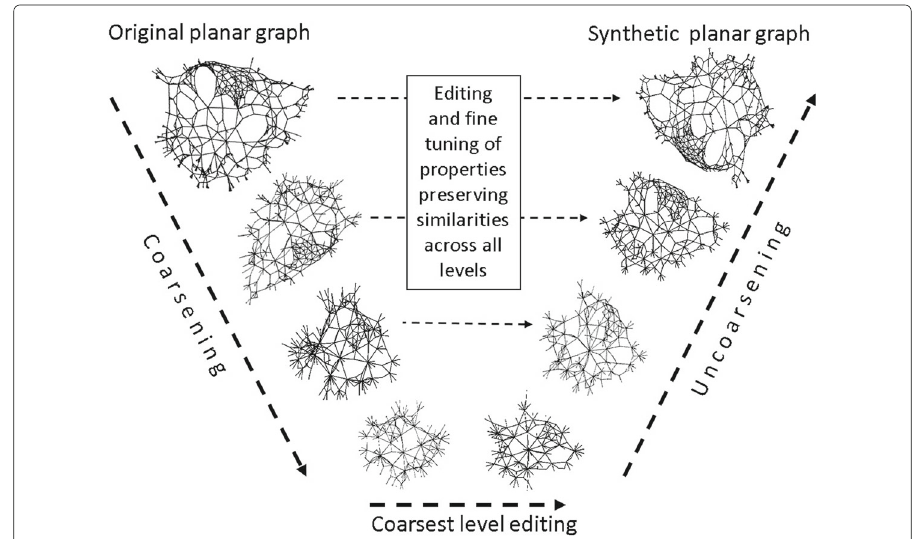
Fig. 1 The V-model for multiscale planar network generation. The original input planar network is coarsened to generate a hierarchy of coarse networks, the process is then reversed generating fine-level networks. The number of level (here 5) depends on the size of input network or the user input